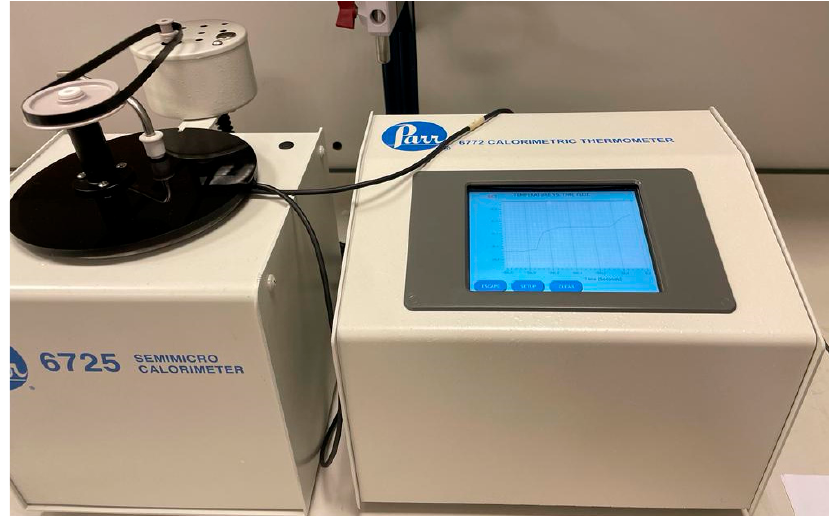
Figure A4. Bomb calorimeter.